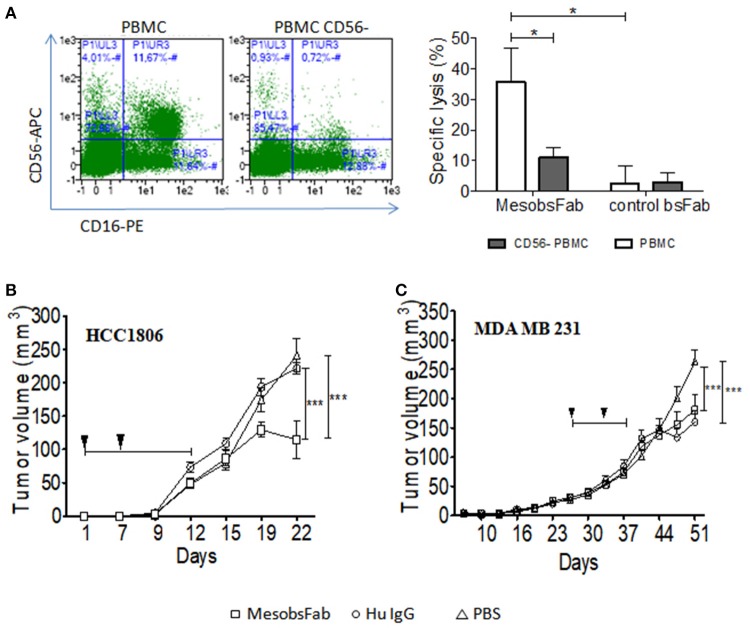
MesobsFab antitumoral efficacy in vivo. (A) Left panel: frequency of CD56+CD16+ cells in PBMC before and after depletion of CD56 cells. The percentage of CD56+CD16+ double-positive cells in the PBMC population is indicated. Cells were labeled with CD56-APC, CD16-PE antibodies. Right panel: flow cytometry-based ADCC assays were performed on 2D cell models using 40 nM of bsFab, unstimulated PBMC (white bar), or CD56-depleted PBMC (gray bar) as effector cells and HCC1806 as target cells (E:T ratio 25:1). CFSE-labeled target cells mortality was determined by staining with TO-PRO3. Specific cell lysis was determined using the formula:: [TEA CFSE+ TO-PRO3+ – TE CFSE+ TO-PRO3+/100 – ET CFSE+ TO-142 PRO+] with TEA = Target + Effector + Antibody, TE = Target+ Effector. Data are presented as mean ± SEM of four independent experiments (4 healthy donors). P values were determined by one-tailed unpaired t-test: *P < 0.05; MesobsFab/PBMC vs. MesobsFab/PBMC CD56−; *P < 0.05; MesobsFab vs. control bsFab. HCC1806 tumors (B) and MDA MB 231 tumor (C) growth in NSG mice that received unstimulated human PBMC twice (arrows) and treated with MesobsFab (5 mg/kg) every day for 12 days, irrelevant human IgG (5 mg/kg) 3 times a week or vehicle (PBS), (n = 5–6 mice/group). Duration of treatment is represented by the black line. Tumor growth was followed using a Vernier caliper. Data are presented as mean tumor volume ± SEM. P value were determined by two-way ANOVA with Bonferroni post tests. HCC1806: ***P < 0.001 MesobsFab vs. Hu IgG (D19 and D22); *P < 0.05 MesobsFab vs. PBS (D19), ***P < 0.001 MesobsFab vs. Hu IgG (D22). MDA MB 231: *P < 0.05 MesobsFab vs. PBS (D48), ***P < 0.001 MesobsFab vs. PBS (D51), ***P < 0.001 Hu IgG vs. PBS (D48 and D51).